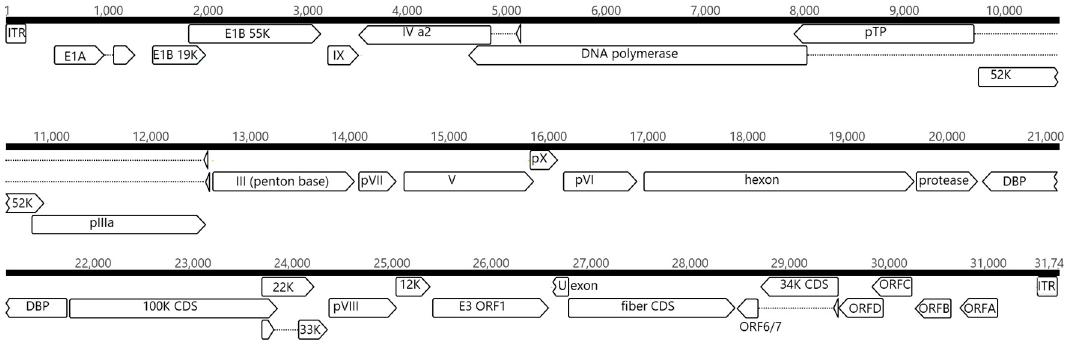
Figure 2. Genomic organization of strain ITA / 2018 / 251170-16. The genome is represented by a black horizontal line marked at 1000-bp intervals. The predicted ORFs are shown as arrows. Dashed lines represent potential splicing mechanisms.